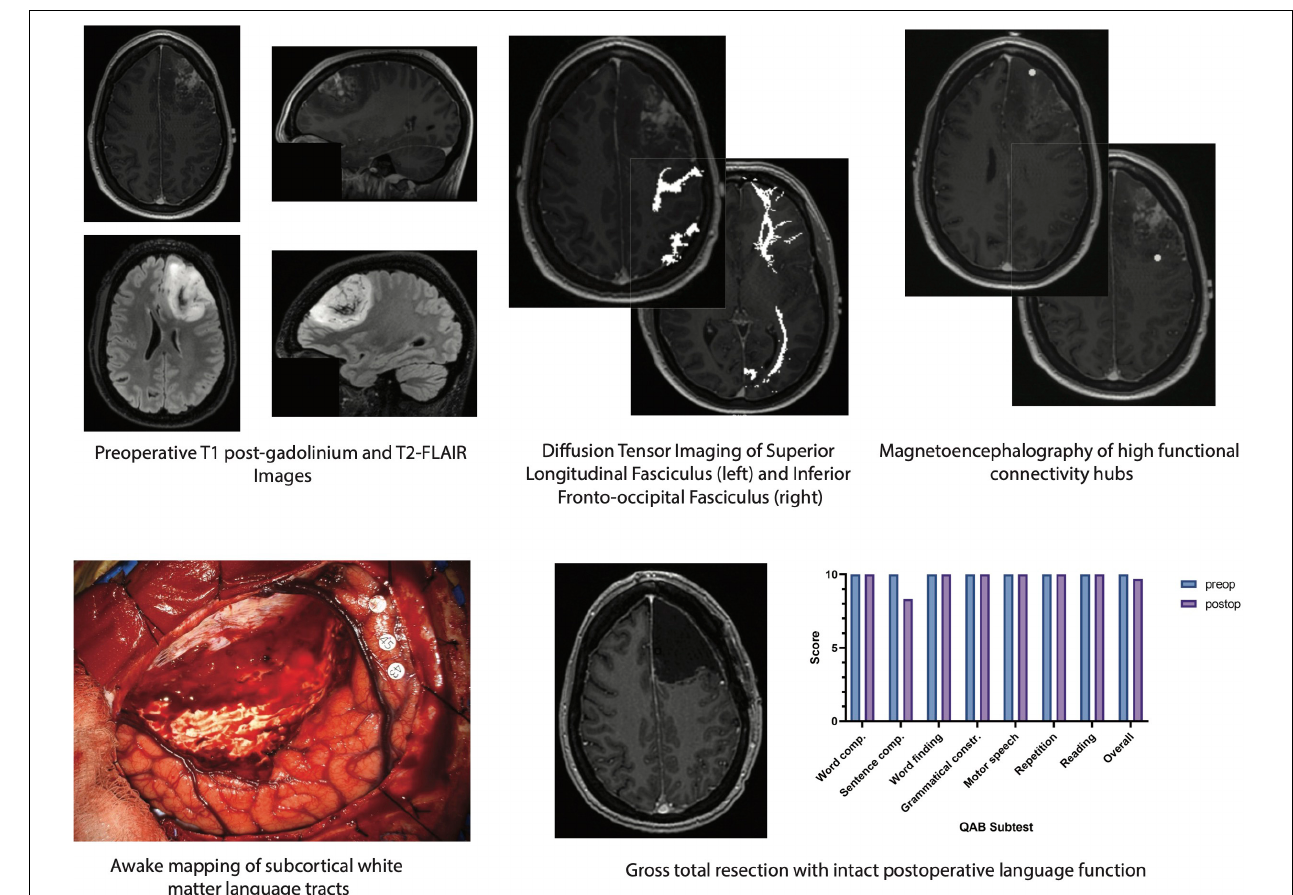
FIGURE 1 | Schematic of multimodal mapping paradigm used to localize and preserve critical white matter structures involved in language function in a patient with a dominant-hemisphere high-grade glioma. ( Top, from left to right ) preoperative imaging demonstrates an expansile contrast-enhancing mass involving the left superior and middle frontal gyri with non-contrast-enhancing signal extending into the subcortical white matter. Diffusion tensor imaging with anatomic seeding reveals several white matter language tracts in close proximity to the tumor including the superior longitudinal fasciculus. The inferior fronto-occipital fasciculus is located deep to the tumor and may be encountered if supratotal resection is pursued. Magnetoencephalography/magnetic source imaging, which can identify regions of high functional connectivity by measuring alpha-band imaginary coherence, shows a hub in the posterior margin of the tumor. ( Bottom, from left to right ) eloquent white matter language tracts are identified in real time via awake craniotomy with direct electrical stimulation. Gross total resection of the contrast-enhancing lesion is achieved while leaving structural and functional connections intact, enabling preserved language function even by 2 days postoperative follow-up. Word comp., word comprehension; Sentence comp., sentence comprehension; Grammatical constr., grammatical construction; QAB, quick aphasia